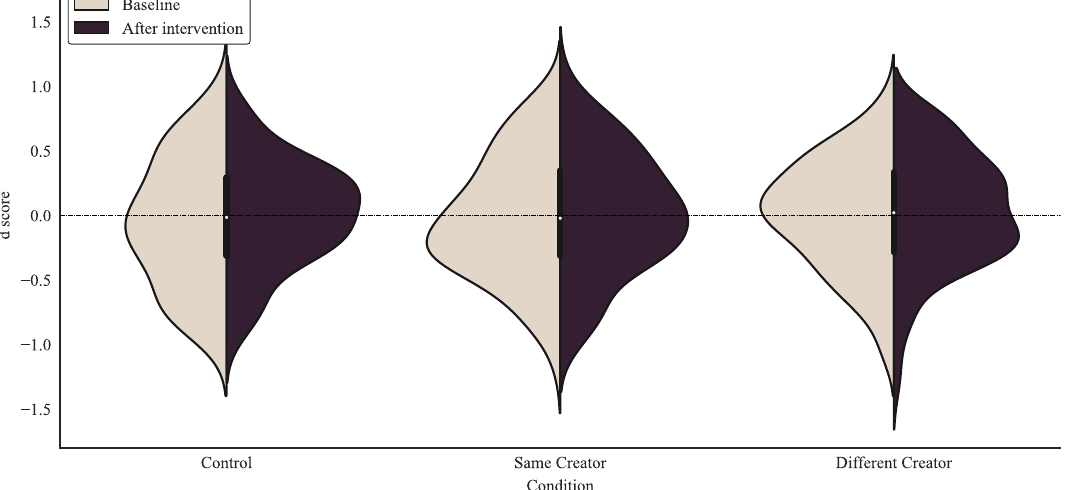
Figure 3. Implicit prejudice d scores (as measured by the IAT) pre- and post-intervention for each condition. Positive (resp. negative) values of d represent less (resp. more) prejudice towards people with mental health issues (w.r.t. physical health issues).